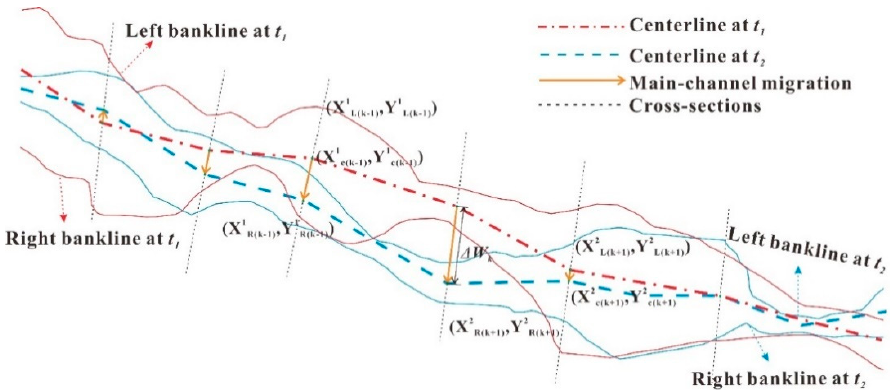
Figure 8. Sketch map for determination of the centerline migration rate at section-scale.